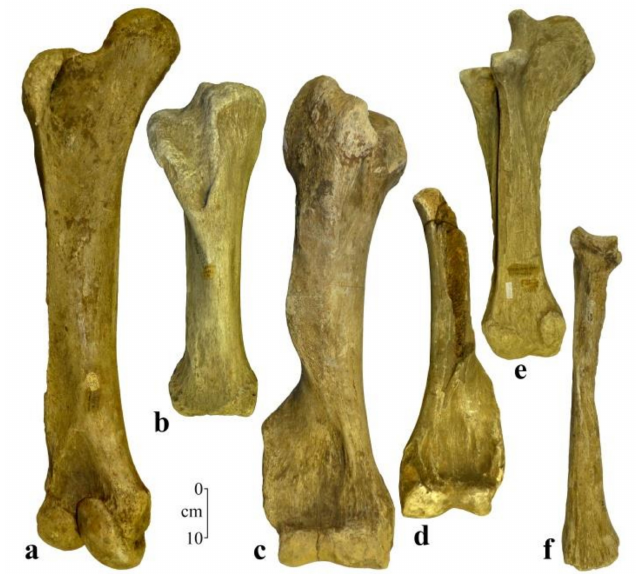
Figure 4. Long bones of post-cranial skeleton of Mammuthus intermedius from Kamensk-Shakhtinskiy (the early Late Pleistocene; Rostov Region, Russia): ( a )—NMDC No. Pal-57, left femur, posterior view, ( b )—NMDC No. Pal-189, right tibia, anterior view, ( c )—NMDC No. Pal-61, right humerus, anterior view, ( d )—NMDC No. Pal-59, incomplete left humerus, anterior view, ( e )—NMDC No. Pal-213, left ulna, lateral view and ( f )—NMDC No. Pal-173, right radius, medial